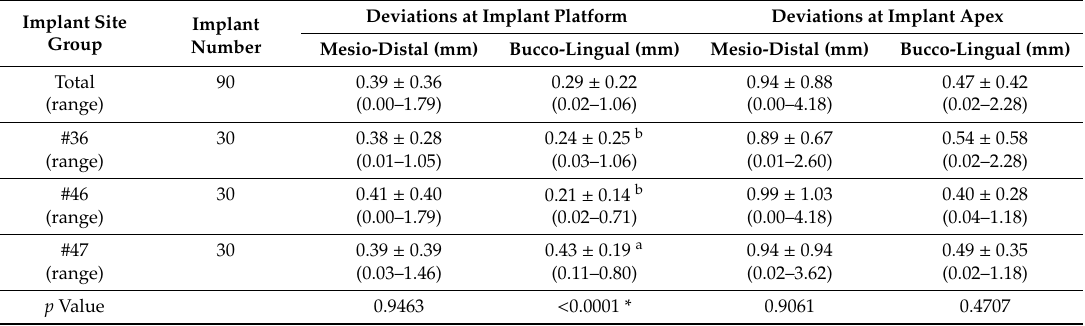
Table 2. Mesio-distal and bucco-lingual deviations between the planned and placed implant position. Implant Site